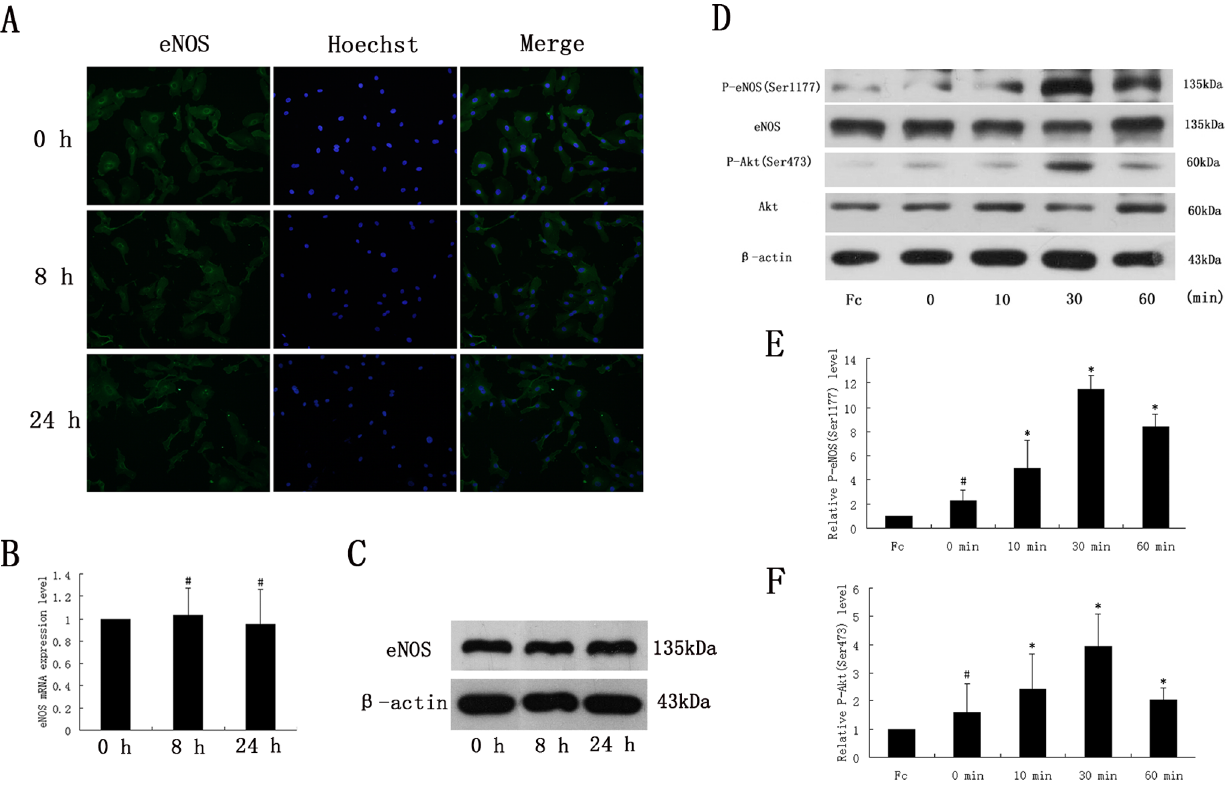
Figure 3. Effect of ephrin-A1-Fc on expression and phosphorylation of eNOS and Akt in HUVECs. HUVECs were exposed to ephrin- A1-Fc (1 m g/ml) for 0 h, 8 h, 24 h. Immunofluorescence (A), Real-time PCR (B) and Western blot analysis (C) demonstrated that ephrin-A1-Fc had no effect on eNOS expression of HUVECs ( # , P . 0.05, n=3). D: Western blots demonstrating that P-eNOS Ser1177 and P-Akt Ser473 were up-regulated under ephrin-A1-Fc stimulation in a time-dependent manner. E: Quantity analysis of P-eNOS Ser1177 . F: Quantity analysis of P-Akt Ser473. (*, P , 0.05, n=4).